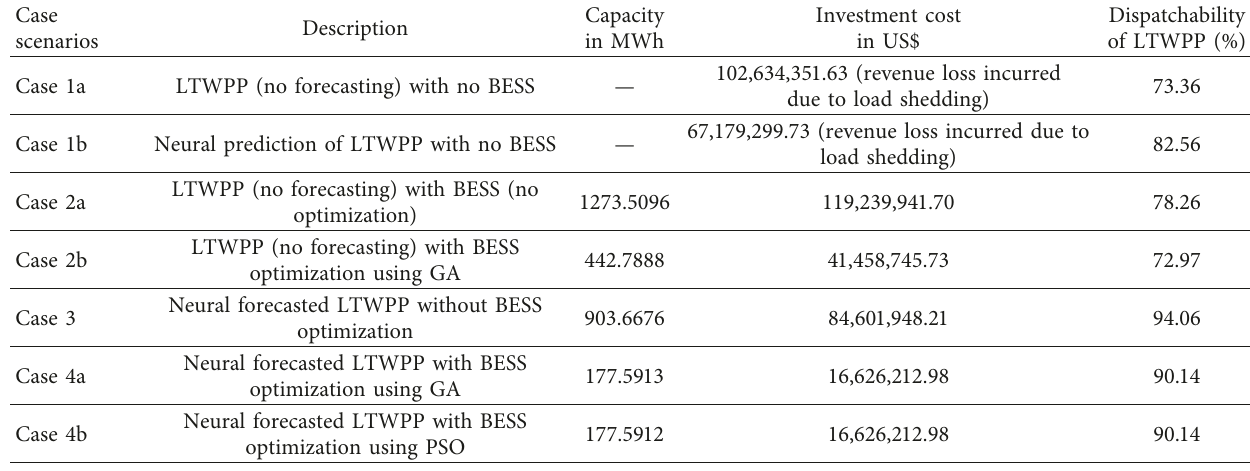
Table 7: Comparison of different cases.